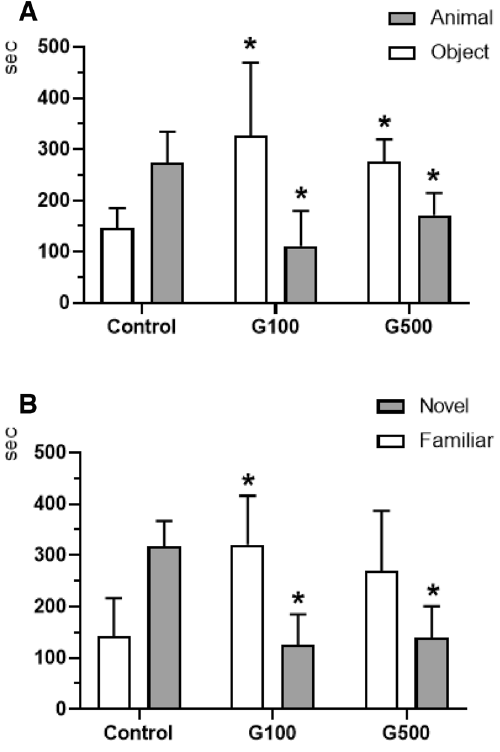
Fig. 2 Effect of low and high dose of Garcinia on sociability ( A ) and social novelty ( B ) in the three chambers social interaction test. Data are plotted as mean ± SD (n = 7). *Significantly different from con- trol